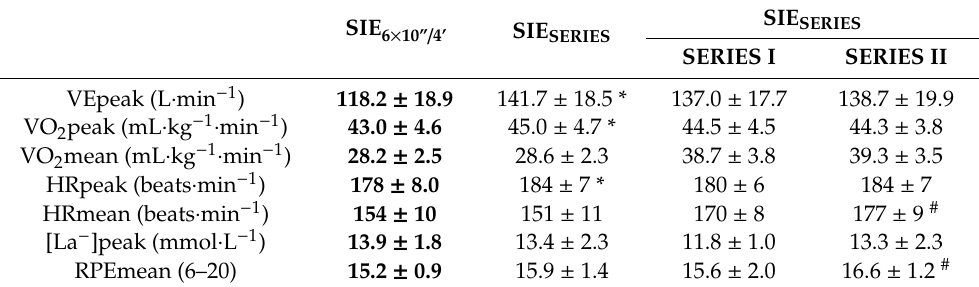
Table 3. Comparison of physiological and perceptual responses between both SIE protocols.